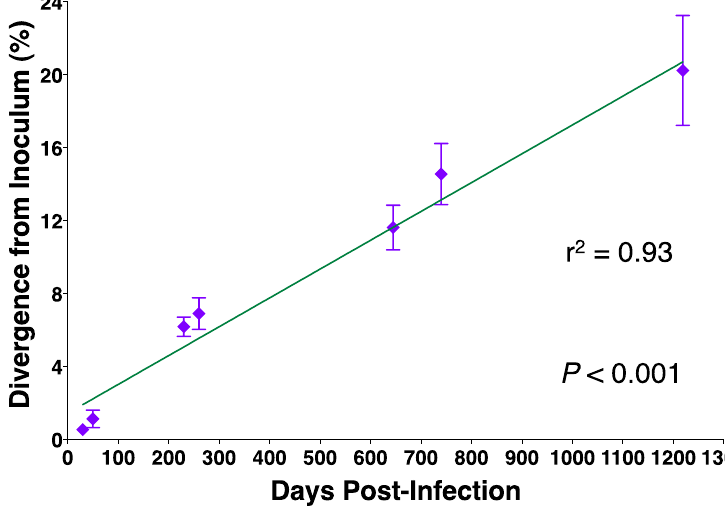
Figure 3. EIAV envelope divergence over time. Genetic distance calculations of amino acid sequence divergence of longitudinal isolate Envs from the inoculum Env sequence were calculated and plotted as a function of time. Linear regression (line) analysis revealed a significant linear relationship between the two variables (Figure modified from original published in Craigo et al.